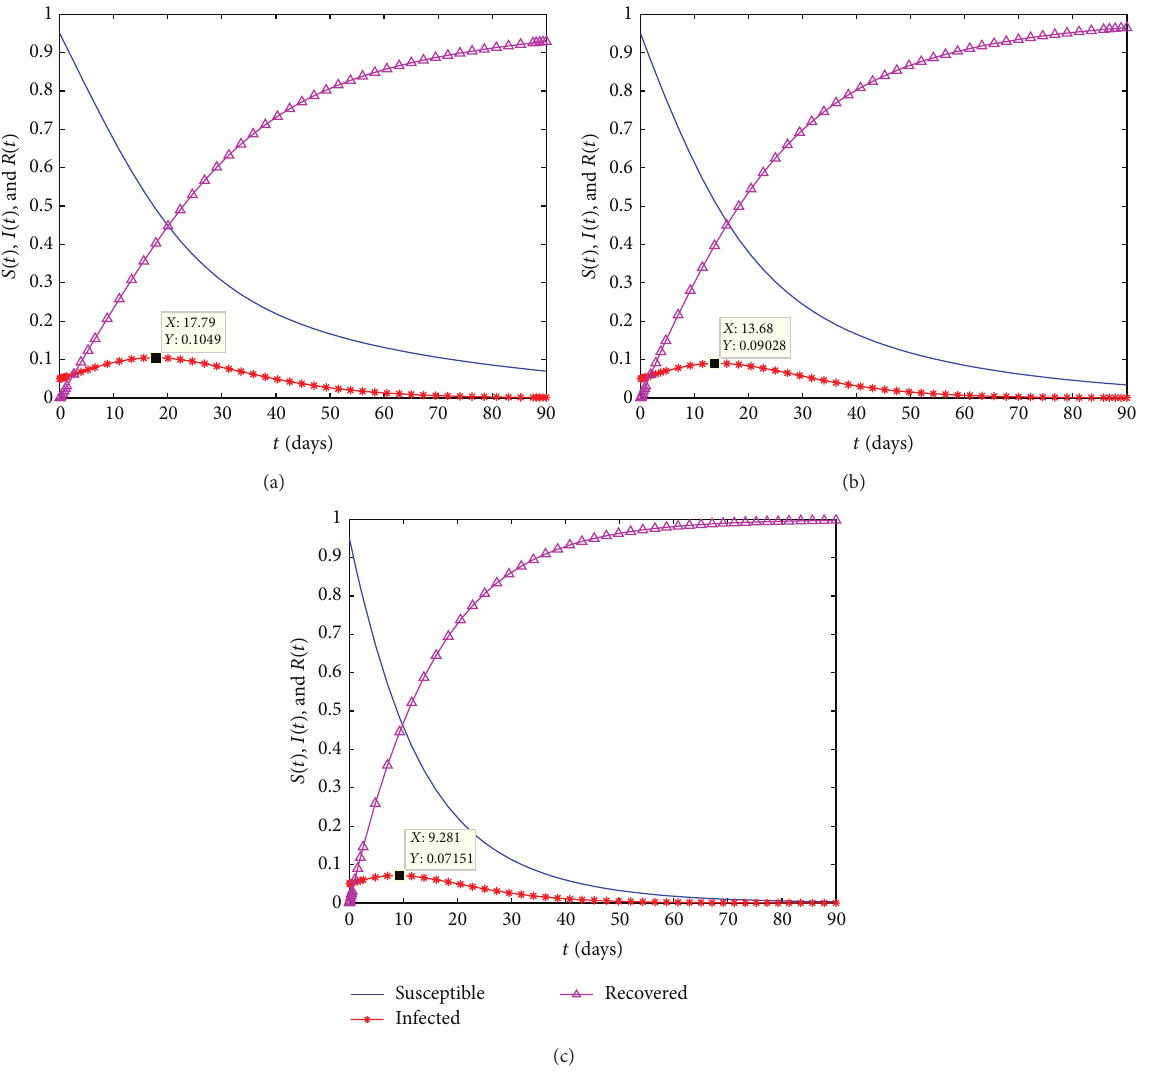
Figure 7: A solution to the SIR model (6) with 𝛽 = 0.2 , 𝜇 = 0.1 , 𝑆(0) = 0.95 , 𝐼(0) = 0.05 , 𝑅(0) = 0 , and different rates of vaccination: 𝜐 = 0.02 (a), 𝜐 = 0.03 (b), and 𝜐 = 0.06 (c).